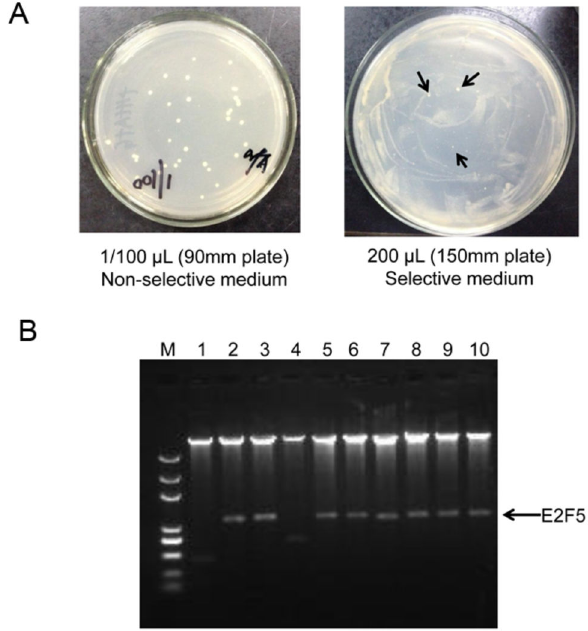
Figure 5. Specificity test for library screening via this system. (A) Performance of orfA screening in a library. Hybrid products were plated on non-selective and selective plates respectively. (B) Double digestion of library plasmids recovered from candidate yeast colonies. To determine the insert size in prey vectors, extracted plasmids from positive colonies were digested by Bam HI and Xho